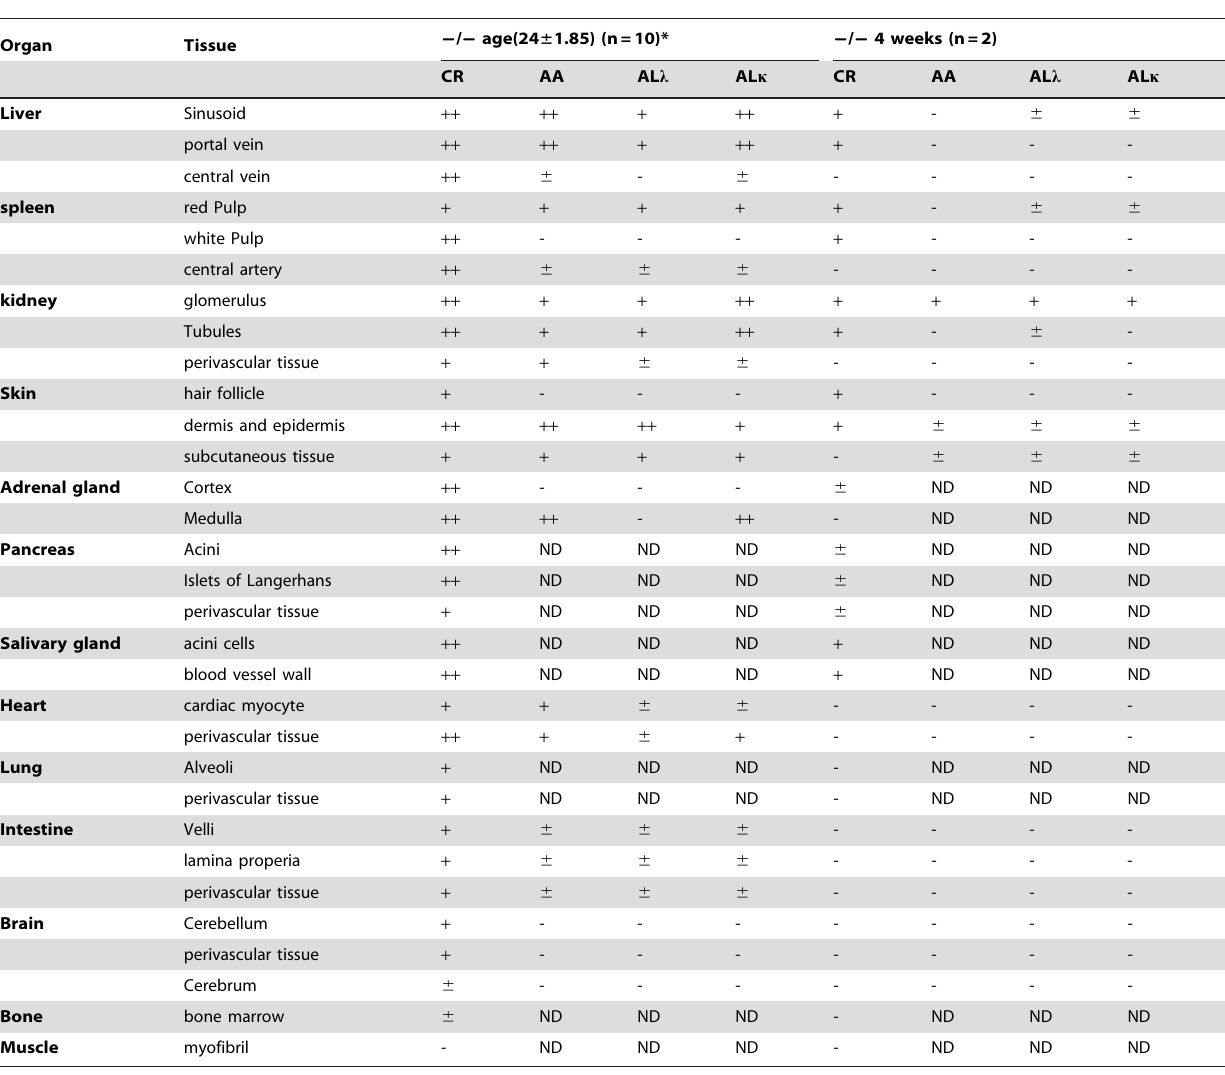
Table 2. Distributions and amyloid type in various tissues of the affected mice using Congo-Red Stain and immunohistochemistry.